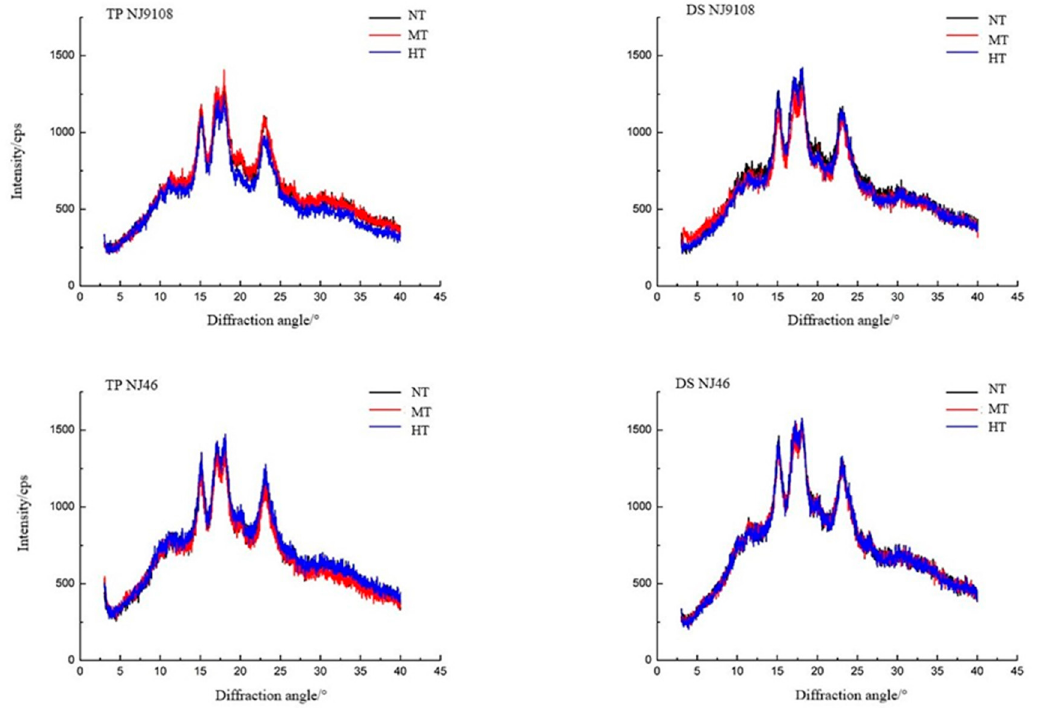
Figure 5. Effects of high temperature on starch crystal structure of japonica rice in early heading stage under transplanting and direct seeding.